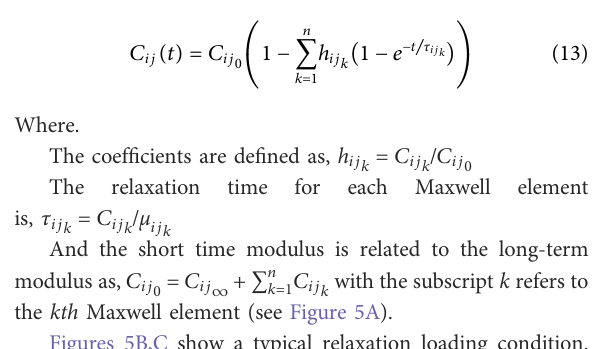
C (cid:2) C 13 31 , and